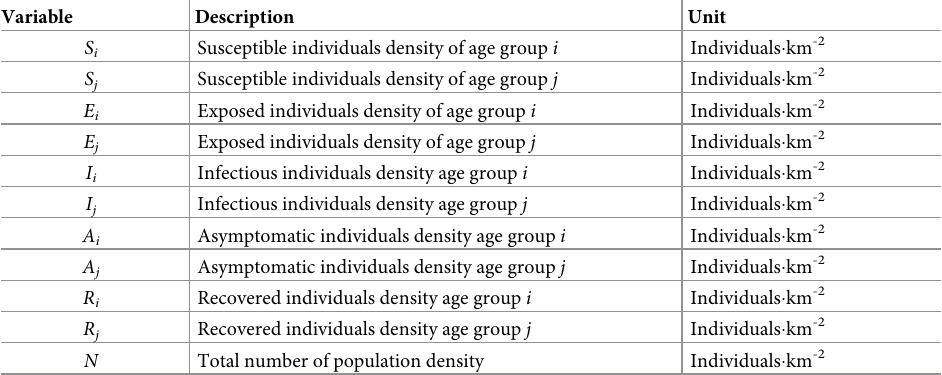
Table 1. Variables with the age groups transmission SEIAR